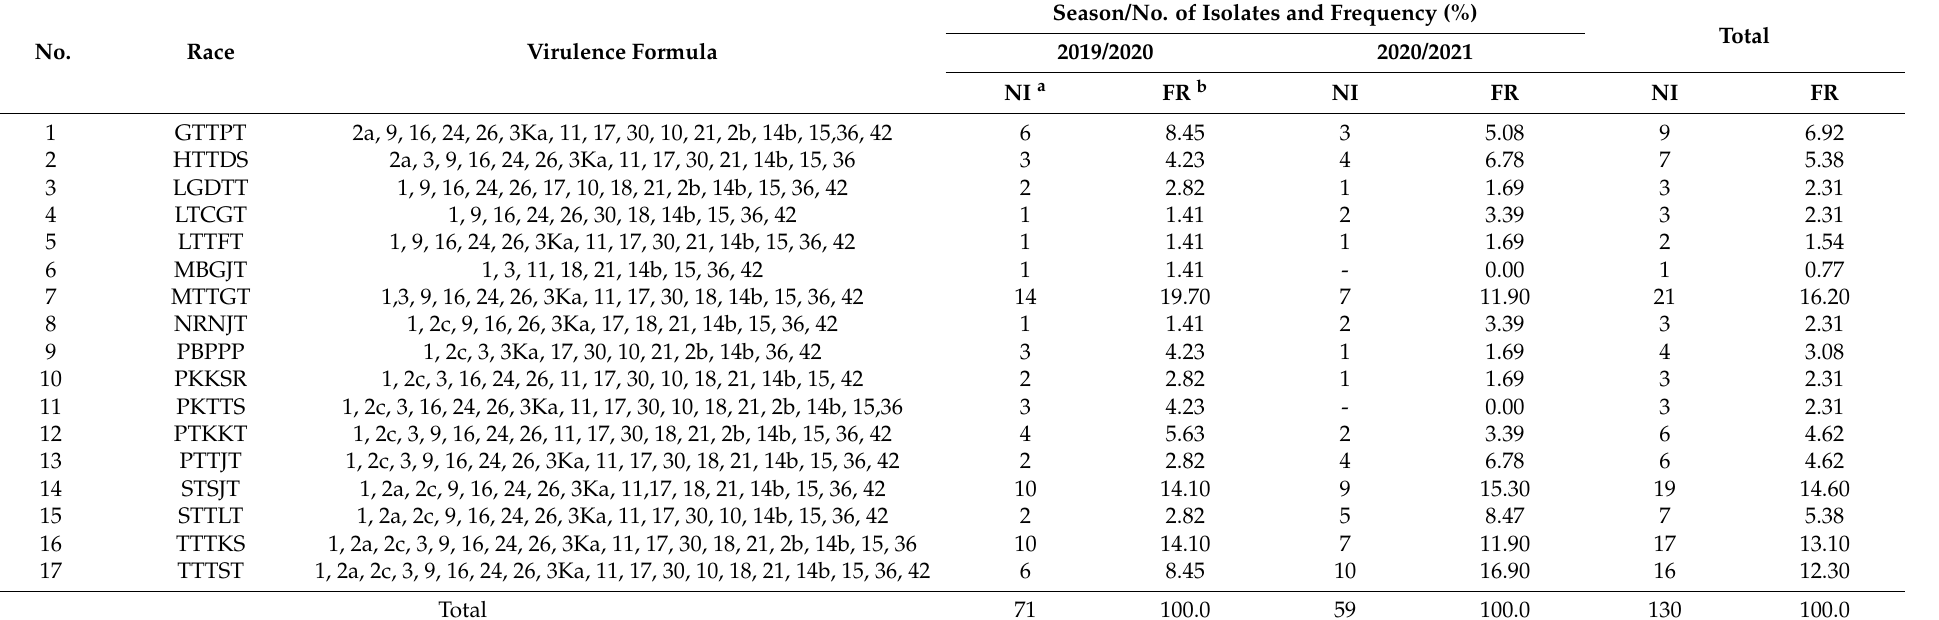
Table 4. Leaf rust races, virulence formula, number of isolates, and frequency (%) of P. triticina collected from wheat cultivars cultivated in various wheat-growing areas in Egypt, during 2019/20 and 2020/21. Monitoring of leaf rust virulence pattern through virulence formula was done on the basis of reaction types in a host pathogen system. Season/No. of Isolates and Frequency No. Race Virulence Formula